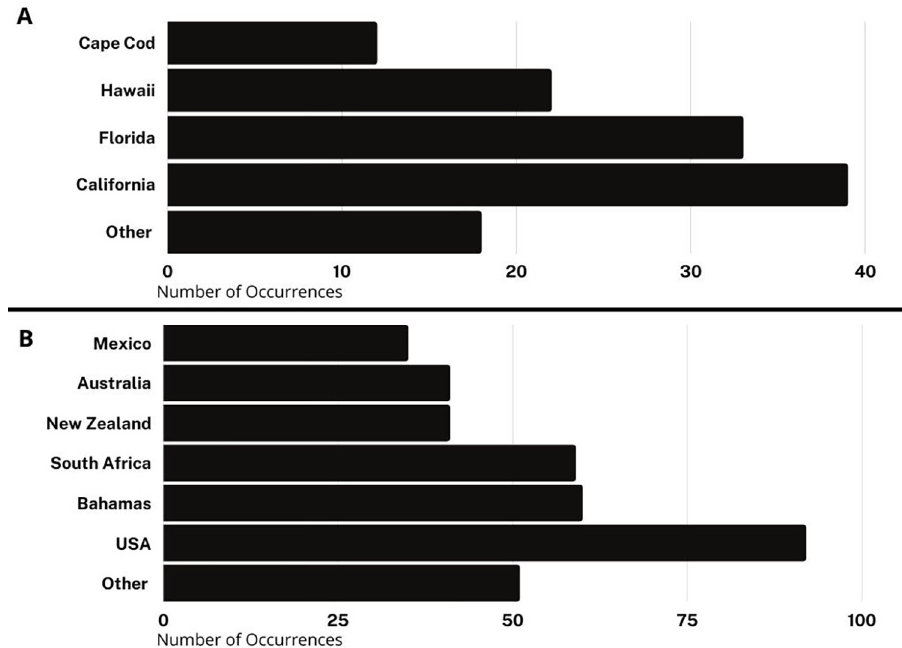
Fig 8. Shark Week filming locations. (A) Locations by country; (B) Locations within the United States. Featured localities: U.S., Bahamas, and South Africa take the lead. Though dozens of countries were featured in at least one episode each, a handful of filming locations dominated. The United States was the most common filming location (24.2% of all episodes), followed by the Bahamas and South Africa with 15% each, and New Zealand, Australia, and Mexico with approximately 10% each (Fig 8). Within the United States, 31.5% of episodes took place in Cal- ifornia, followed by Florida (26.7% of episodes), Hawaii (17.8% of episodes), and Massachu- setts (9.6% of episodes). At least one episode took place in nearly every coastal state’s waters (except for Delaware, and noting that most shows featured in Georgia were filmed at the Geor- gia Aquarium). However, most states other than Florida, California, Hawaii, and Massachu- setts were not featured often, and some states were featured only once. In the post-hoc reliability analysis, 66 locations were identified by coders, who agreed on 63 of those locations, for an agreement of 95.4% and a Kohen’s Kappa of 0.91 (Almost Perfect Agreement). For each location of disagreement, two occurred in episodes briefly featuring many locations and one was missed by one coder.